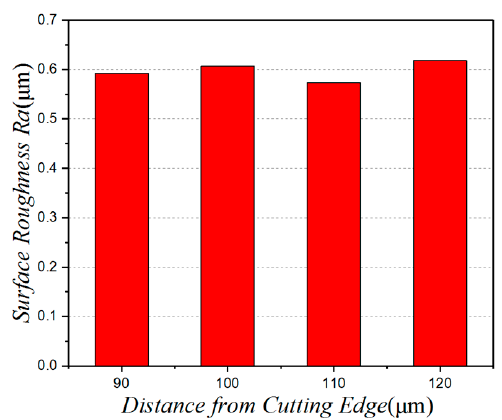
Figure 10. The influence of the distance between the micro ‐ texture and the cutting edge on the surface roughness.